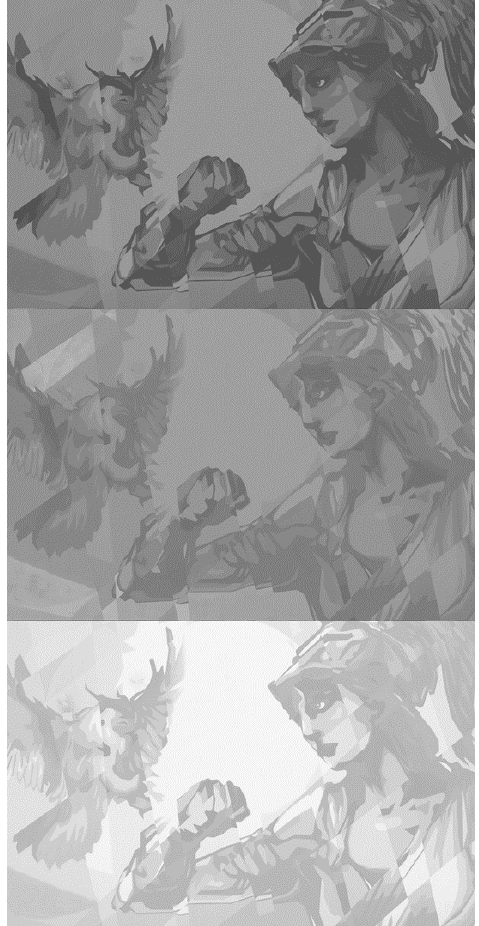
Figure 3: From Top to bottom: Athena, Red, Green and Blue difference maps for AHD algorithm